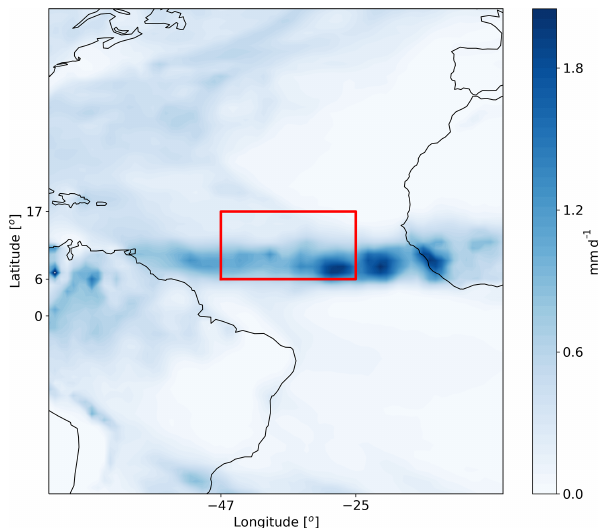
Figure 1. Domain of the ICON simulations (red rectangle) overlaid on the August 2016 ECMWF ERA-Interim reanalysis (Dee et al., 2011) mean precipitation